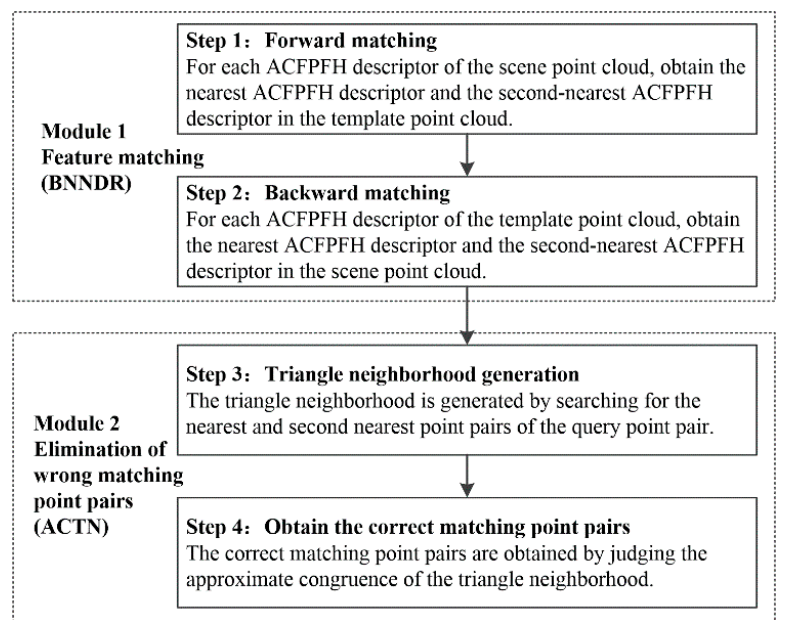
Figure 7. The flowchart the proposed surface matching method. Module 1: Feature